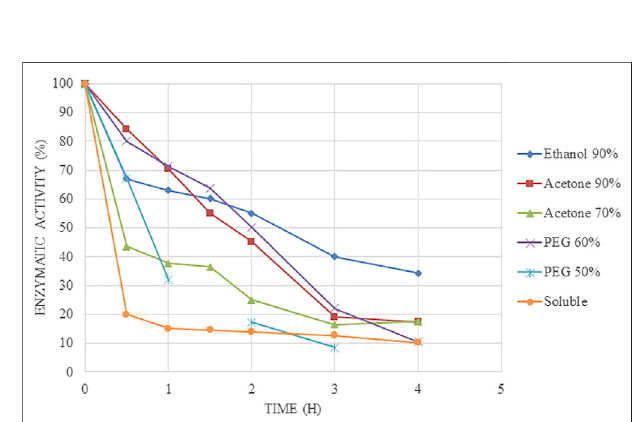
FIGURE 2 | Time course of inactivation at 55 ° C and pH 5.0 at different times of Alcalase ® -CLEAs using PEG, ethanol, and acetone as precipitants.